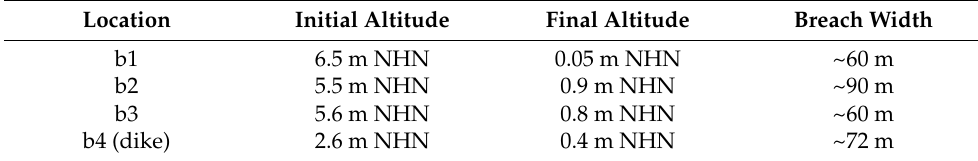
Figure 16. Dune breaches in the study area Ahrenshoop after the second load of the design flood. Table 5. Final geometry of the breaches in the study area of Ahrenshoop.